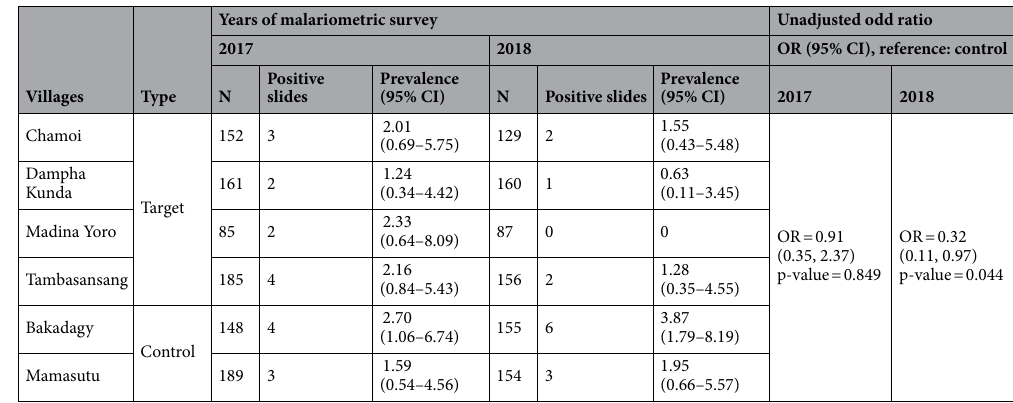
Table 3. Unadjusted Odd Ratio from logistic regression analysis of malaria prevalence in target and control arms.